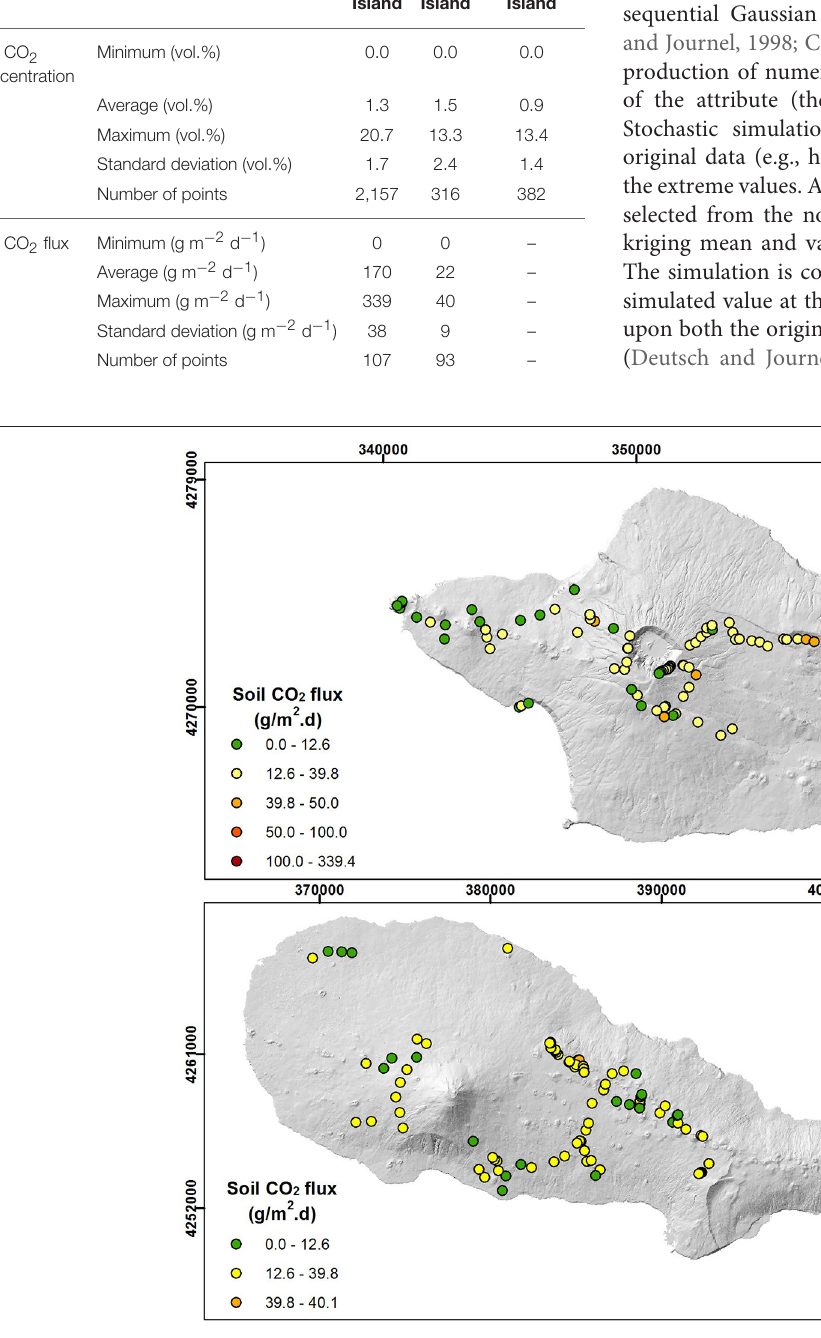
Frontiers in Earth Science |